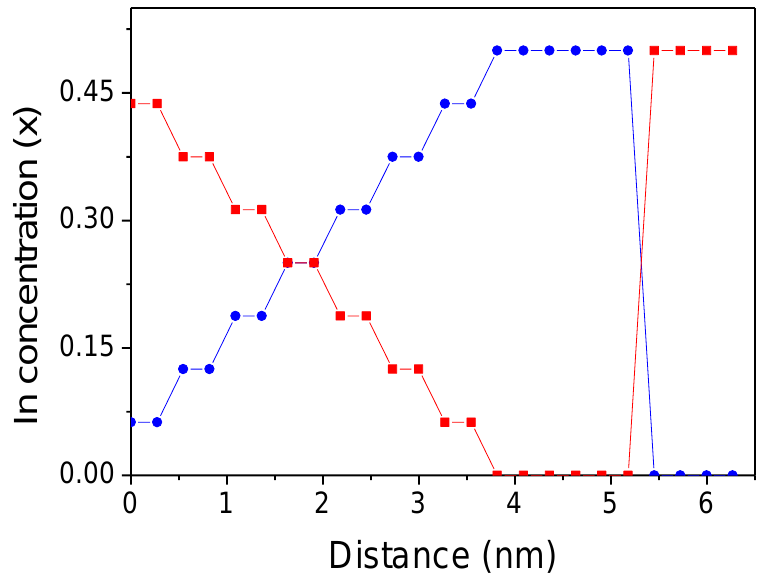
Figure 2. Indium concentration (x) along the [000-1] axis in the structures presented in Figure 1. The zero coordinate is set at the bottom of the cell. The red circles and the blue squares represent indium concentration in the lattice plotted in Figure 1a,b, respectively. The line is for guiding the eye only.